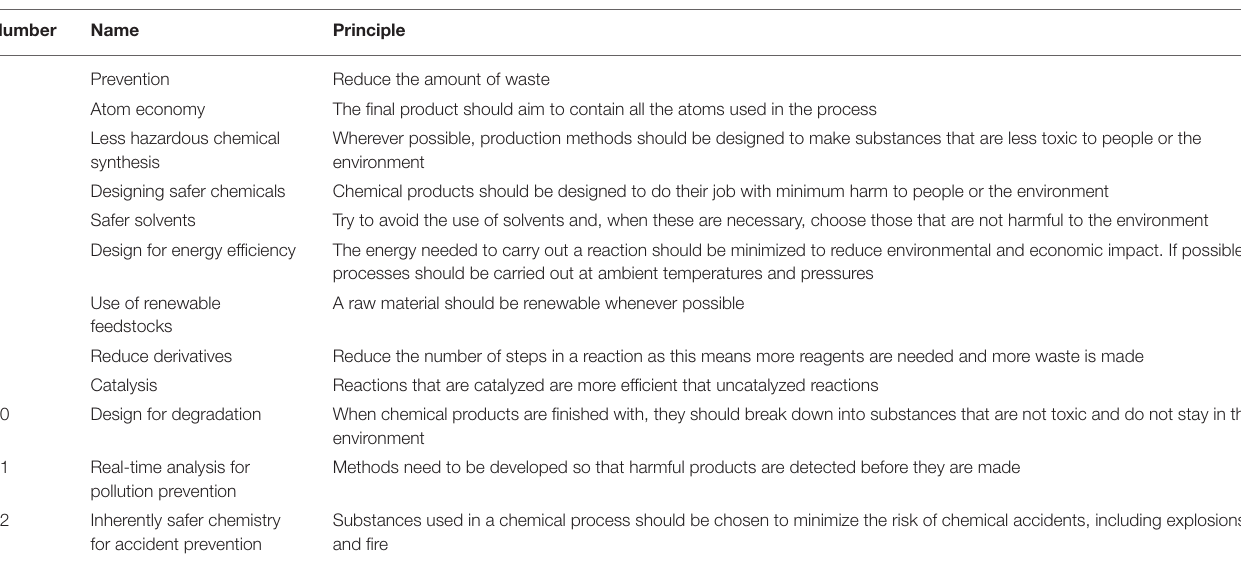
TABLE 6 | The twelve principles of Green Chemistry (Green Chemistry | US EPA,